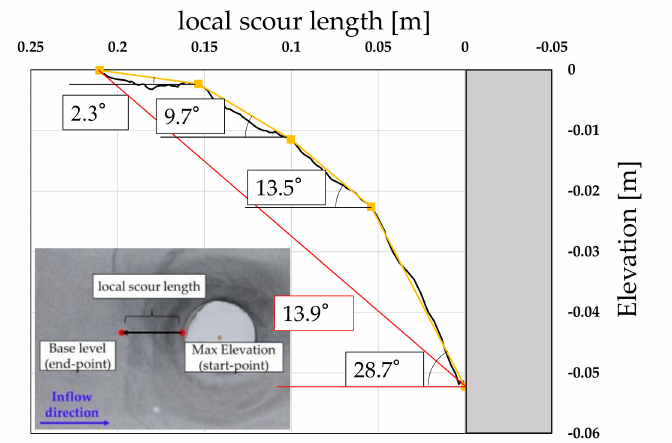
Figure 21. Slope angle of the local scour hole in Case 6 ( N = 10: point